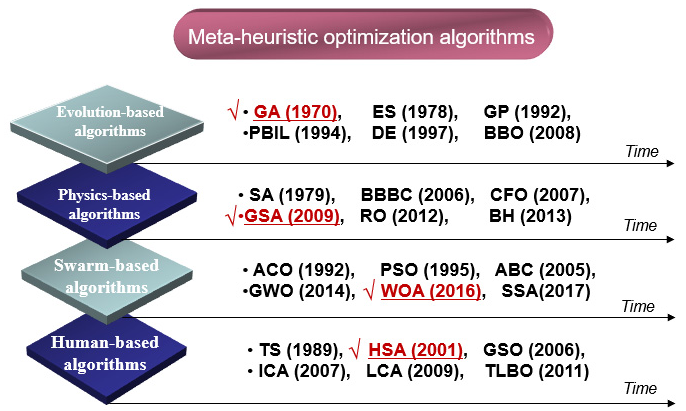
Figure 15. Classification of metaheuristic algorithms.